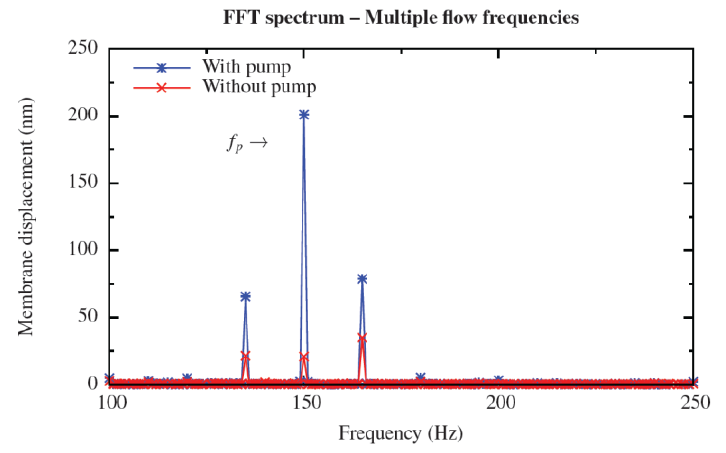
Figure 7. Measured gain of about 20 dB for the flow frequency component at 150 Hz determined by FFT. The AC-bias voltage is fixed at = 150 Hz with an amplitude of 5